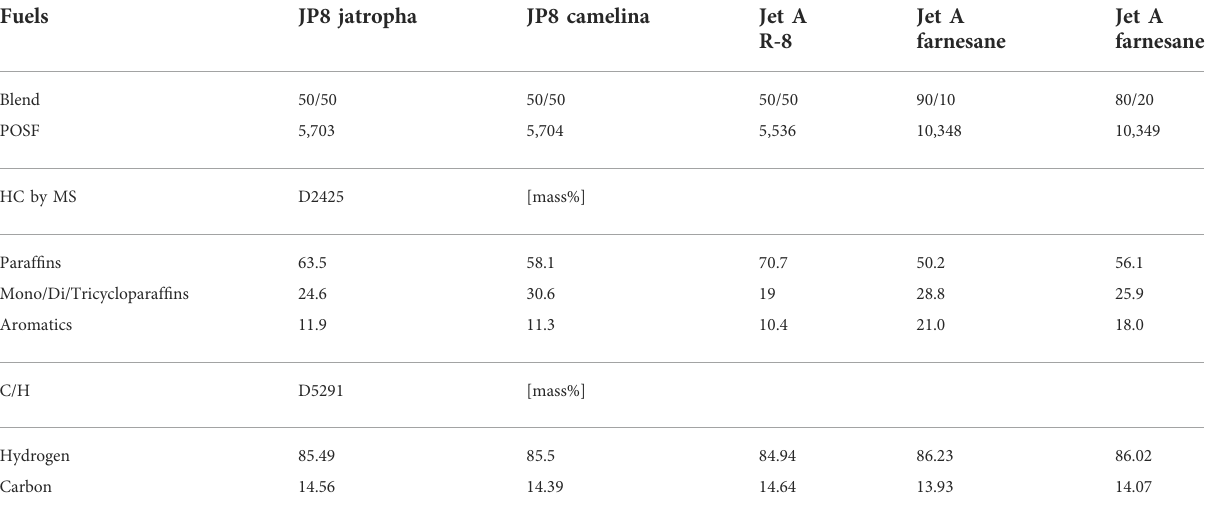
TABLE 3 Compositional analysis for SAF blends.